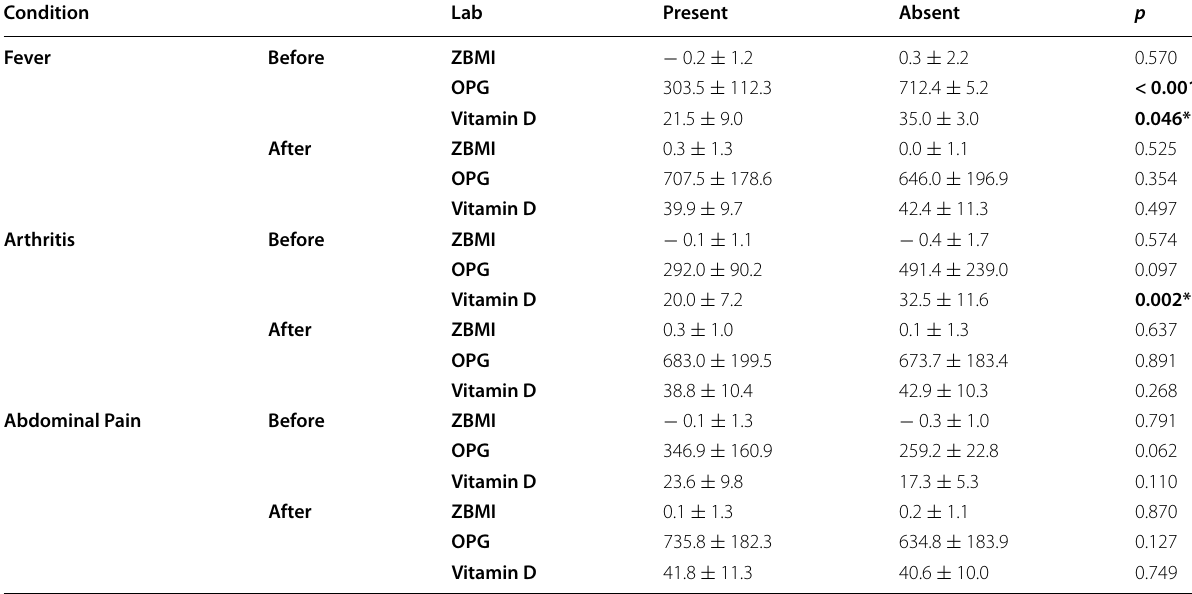
Independent t test. ANOVA test. *Significant